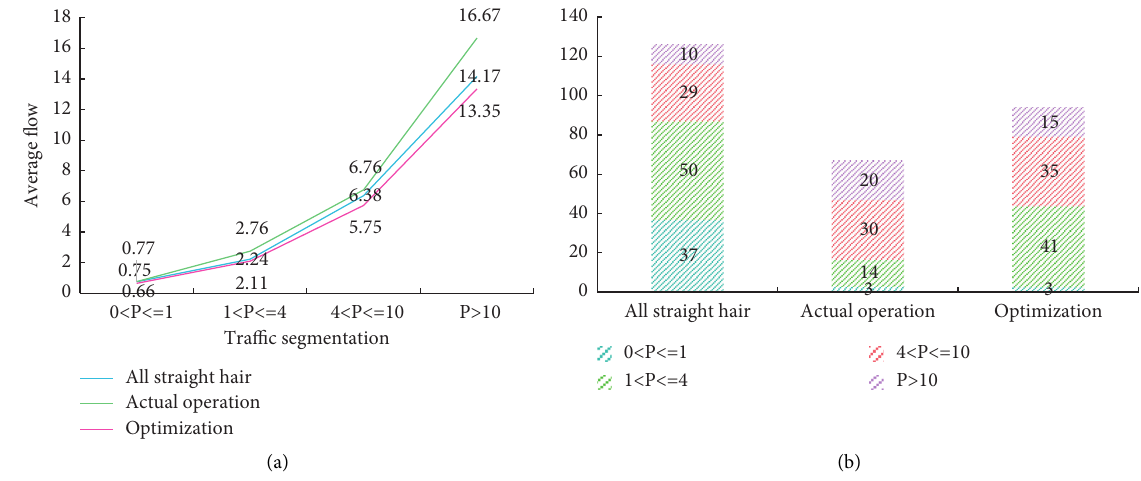
Figure 7: Results of the three schemes for different flow segments. (a) Comparison chart of average flow rates on different flow sections of the three plans. (b) Comparison chart of the number of lines in different traffic sections of the three